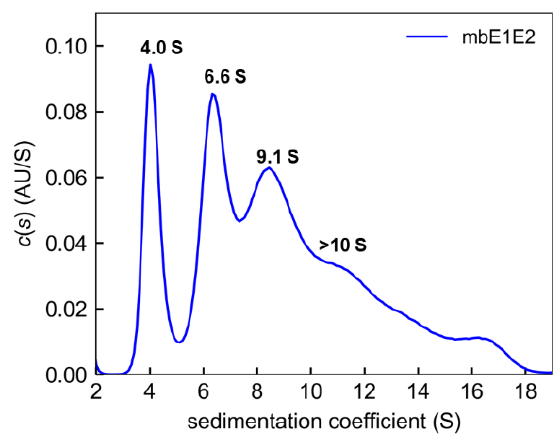
Figure 6. Analysis of mbE1E2 by analytical ultracentrifugation. Shown is the distribution of Lamm equation solutions c ( s ) for mbE1E2 (blue). The coefficients for the peaks are shown. Reproduced with permission from [22].